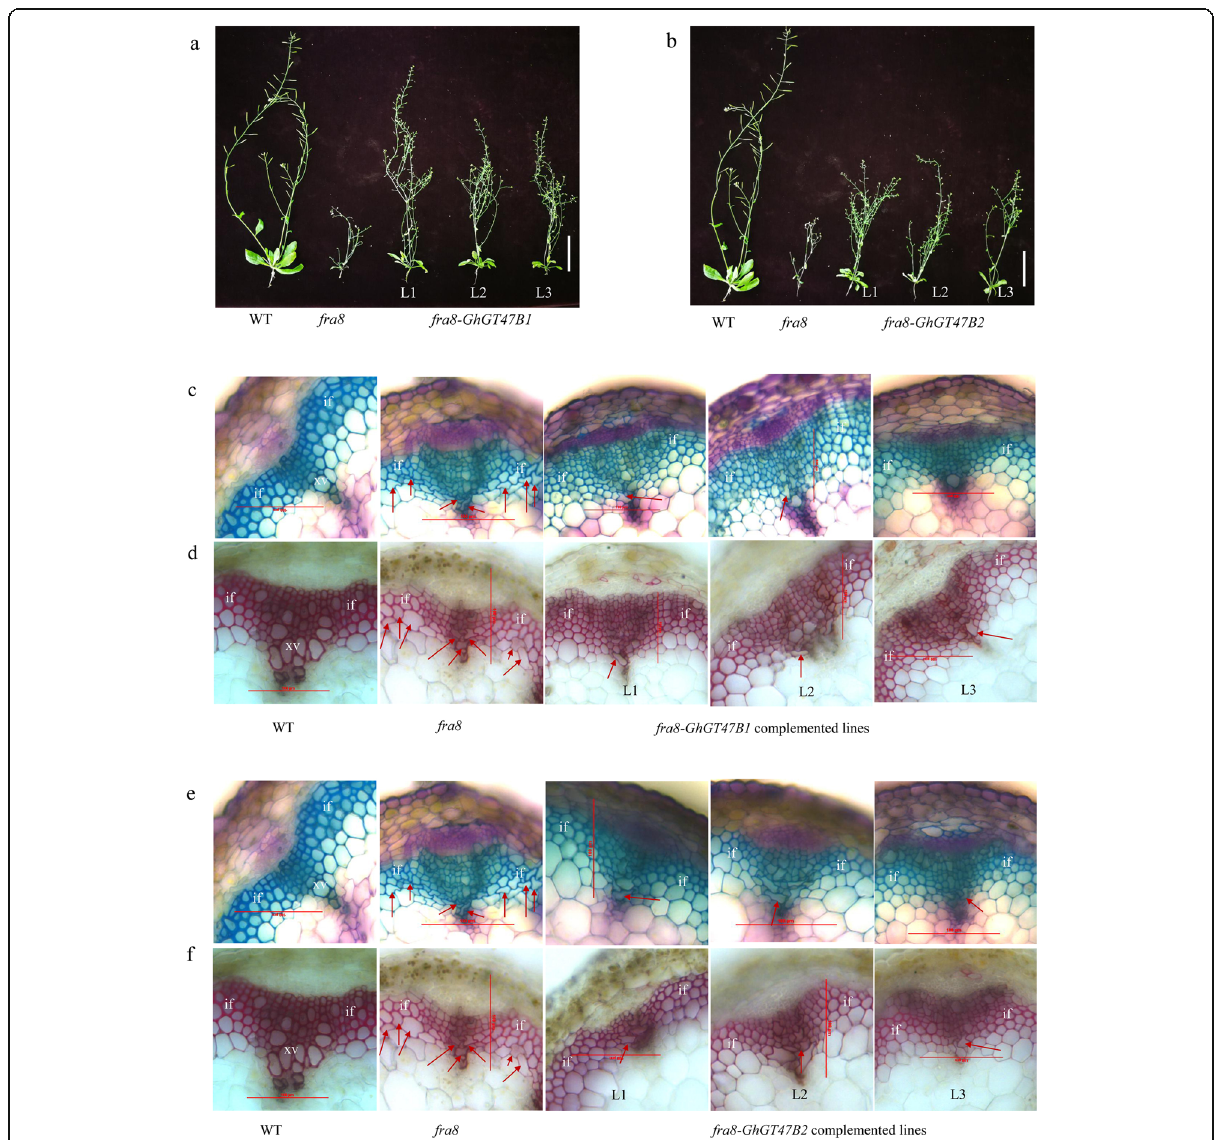
Fig. 5 Expression of GhGT47B1 and GhGT47B2 individually in Arabidopsis fra8 mutant. a 6-week-old plants of wild type, fra8 mutant and three independent GhGT47B1 -complemented fra8 lines. b 6-week-old plants of wild type, fra8 mutant and three independent GhGT47B2 -complemented fra8 lines. c Toluidine blue staining of stem cross sections from 6-week-old wild type, fra8 mutant and three independent GhGT47B1 -complemented fra8 lines. d Phloroglucinol staining of stem cross sections from 6-week-old wild type, fra8 mutant and three independent GhGT47B1 -complemented fra8 lines. e Toluidine blue staining of stem cross sections from 6-week-old wild type, fra8 mutant and three independent GhGT47B2 -complemented fra8 lines. f Phloroglucinol staining of stem cross sections from 6-week-old wild type, fra8 mutant and three independent GhGT47B2 -complemented fra8 lines. WT represents wild type, fra8 shows the fra8 mutant, L1, L2, L3 denote GhGT47B -complemented fra8 lines. Red arrows indicate deformed xylem vessels and interfascicular fibers. xv, xylem vessel, if, interfascicular fibers. Scale bar=5cm (a, b) and 100 μ m (c, d, e, f)